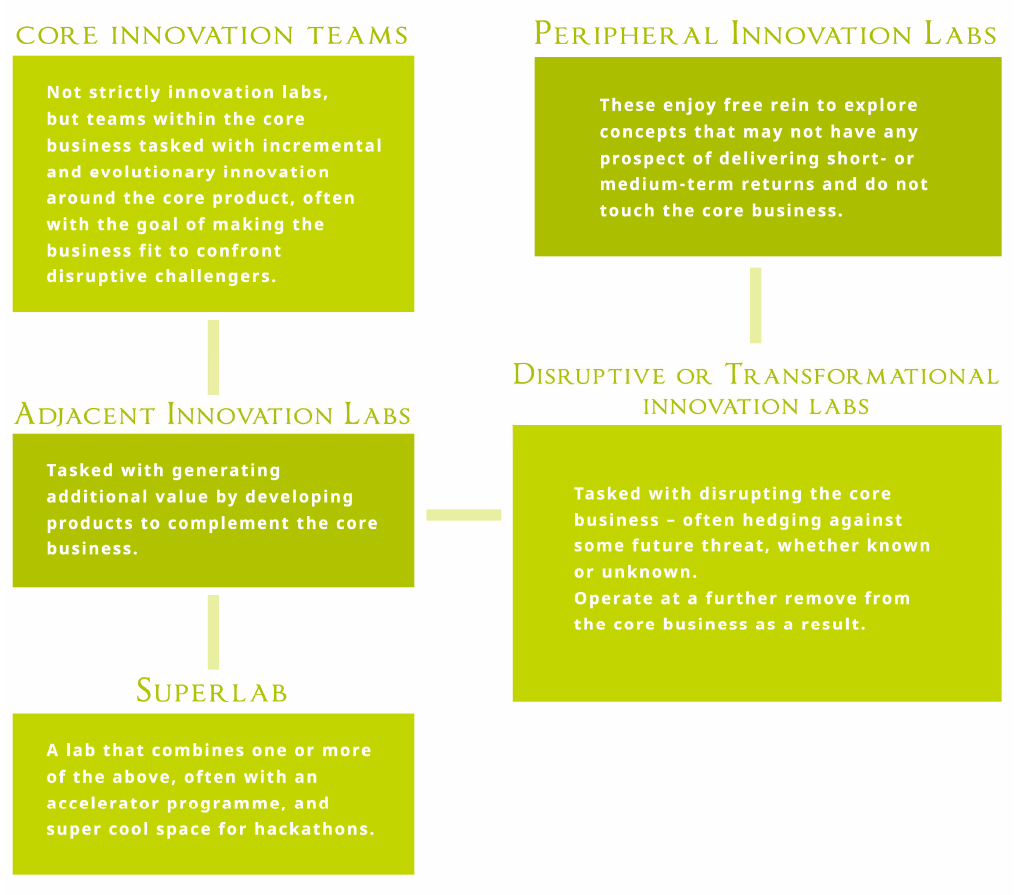
Figure 2: Innovation Teams and